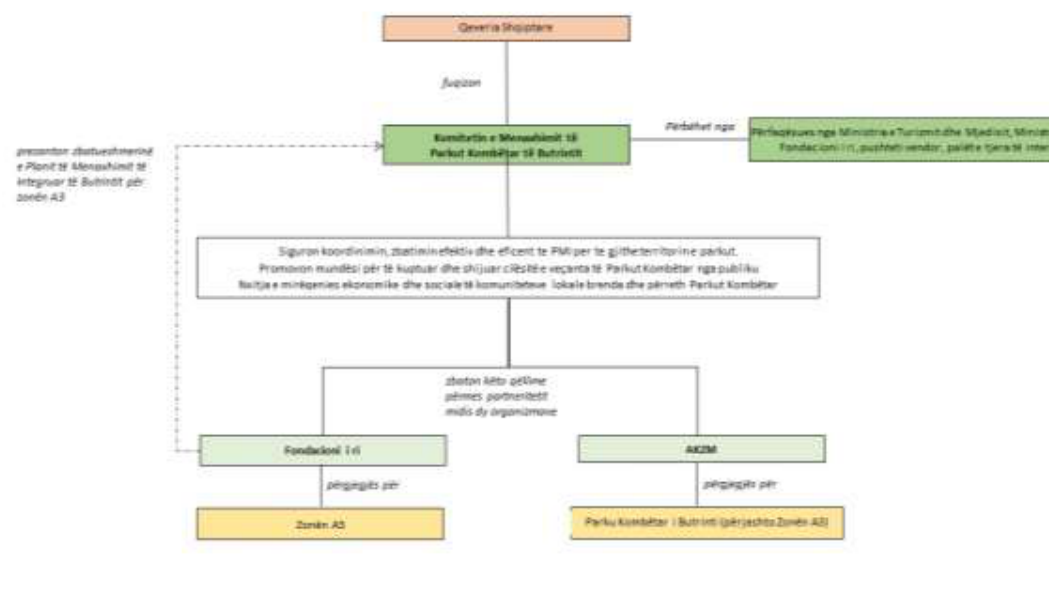
Figure 16 Proposals for the new Butrint National Park Management